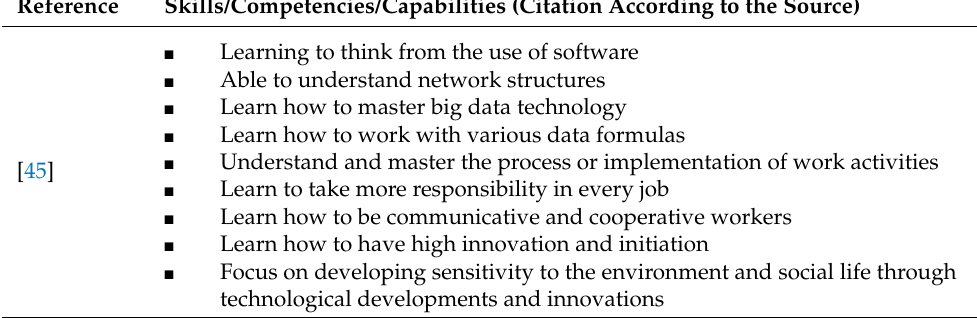
Table 1. Sample lists of workforce skills for Industry 4.0 in exemplary academic and research studies.